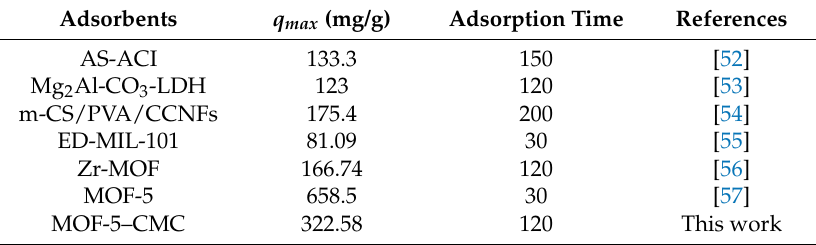
Table 5. Comparison of adsorption performance of MOF-5–CMC with previously reported adsorbents for Pb(II).